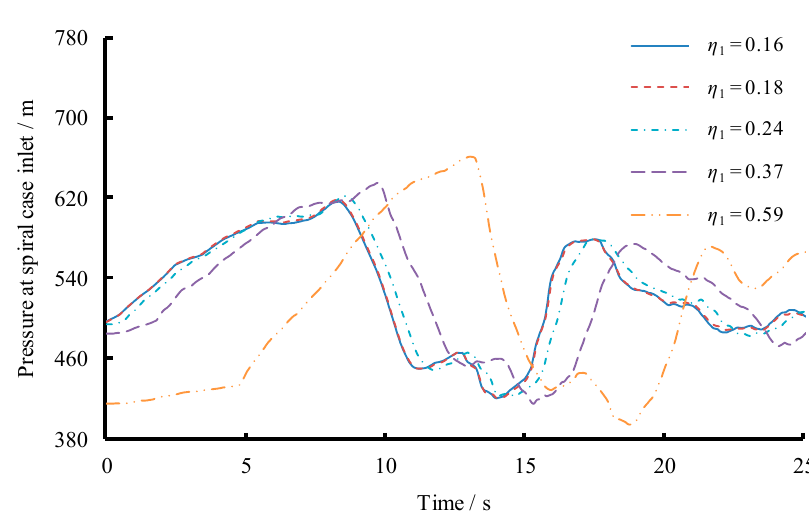
Figure 14. Spiral case pressure of different η 1 versus time for Scenario 2.